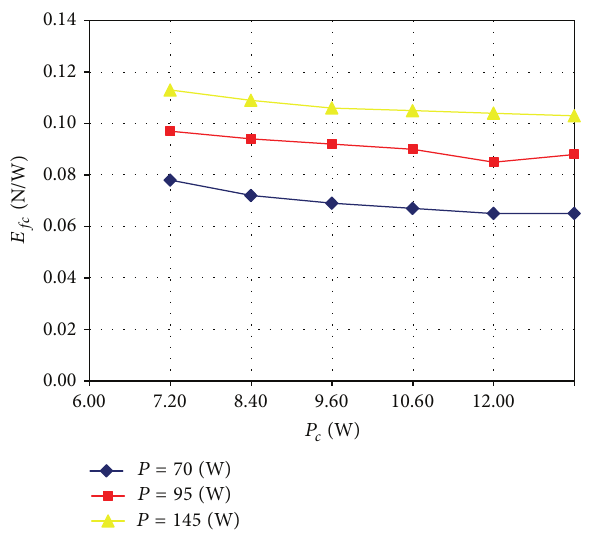
Figure 13: Variation of the tail boom efficiency 𝐸 𝑓𝑐 according to the lateral force 𝐹 and the required power 𝑃 𝑐 throughout the three functioning stages of the main rotor at a pitch angle 𝑝 = 4 ∘ .